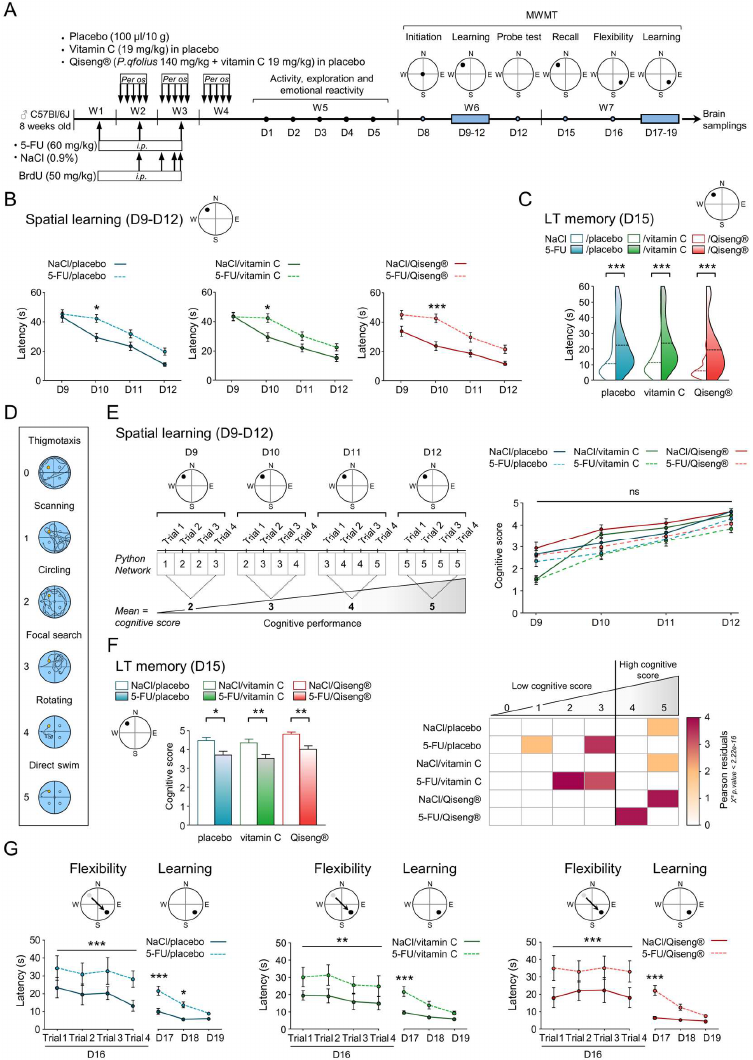
Figure 2. Absence of preventive effect of Qiseng ® on the 5-FU-induced alteration of spatial learning, memory and behavioral flexibility. ( A ) Schematic diagram showing the timeline for treatments and behavioral experiments assessing activity, exploration and emotional reactivity already described in Figure 1 but also the cognitive functions evaluated in the MWMT for the same groups of mice. Mice received one i.p. injection of 5-FU once a week for 3 weeks ( arrow ), while placebo solution, vitamin C (19 mg/kg) in placebo or Qiseng ® ( P. qfolius 140 mg/kg + vitamin C 19 mg/kg) were administered per os once a day, 5 times a week for 3 weeks. Mice also received i.p. BrdU injections (50 mg/kg, once a day for 4 days, arrow ) in W2 and W3. MWMT was performed over 10 days, starting from W5 with the familiarization on D8, the first learning phase from D9 to D12, the probe test on